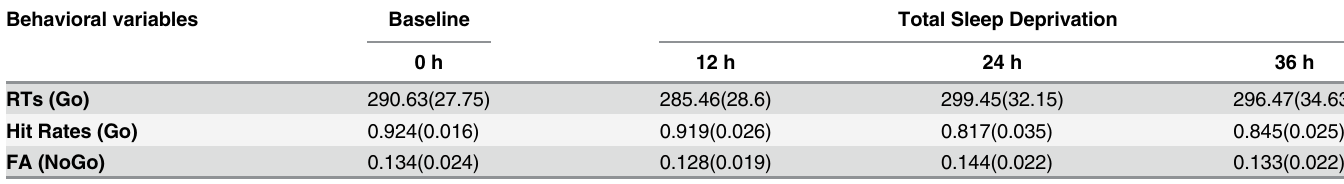
Table 1. The Reaction Time and Hit Rates in Go trials and False Alarms in No-Go trials. Behavioral